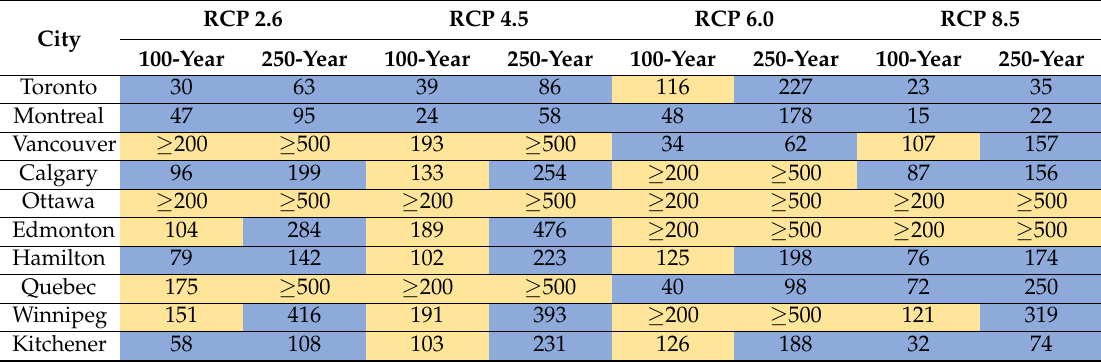
Table 3. Projected future return periods of historical 100-year and 250-year return period flood events for 10 most populated Canadian cities obtained from all GCM median approach. Return periods greater than 200 (500) are only provided categorically in case of 100-year (250-year) return period events. Cases projected with future increases in flooding frequencies are shown in blue whereas cases projected with future decreases in flooding frequencies are shown in